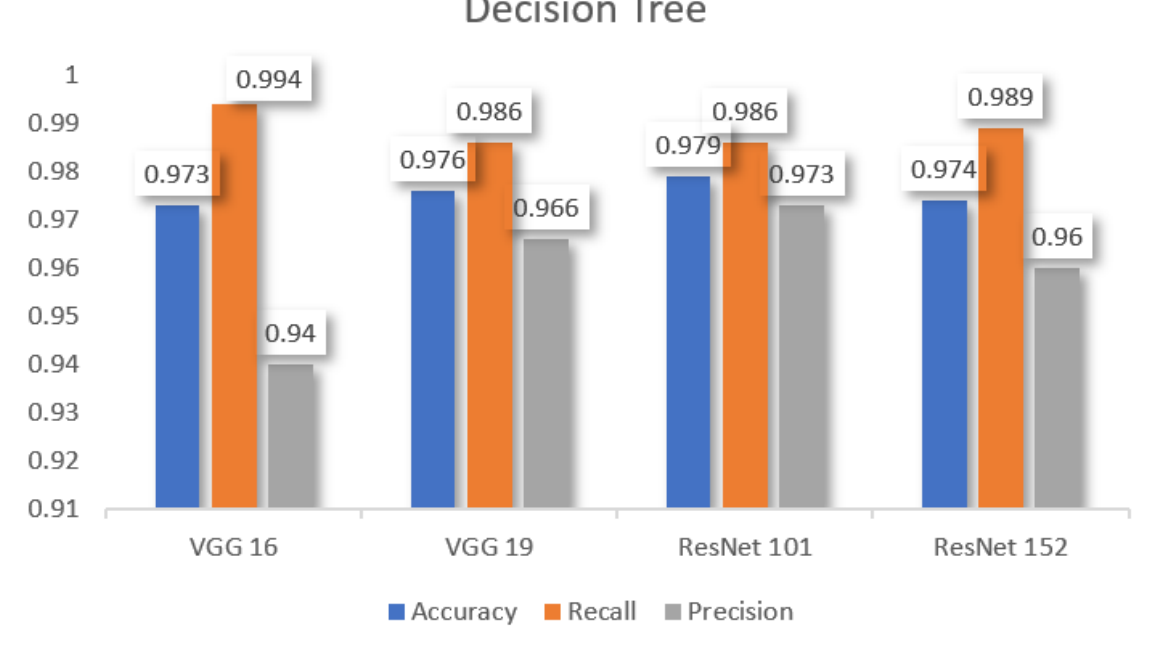
Figure 15. Comparative analysis of the performance metrics among various models using decision tree.